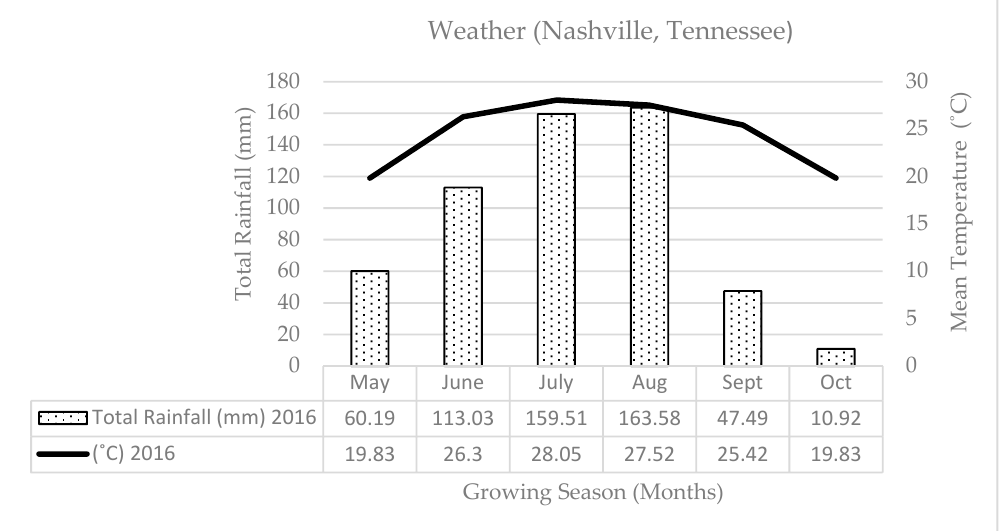
Figure 1. Monthly average climate data (2016)—rainfall and temperature in Nashville, TN, USA. Data were made available from the U.S. Climate Data